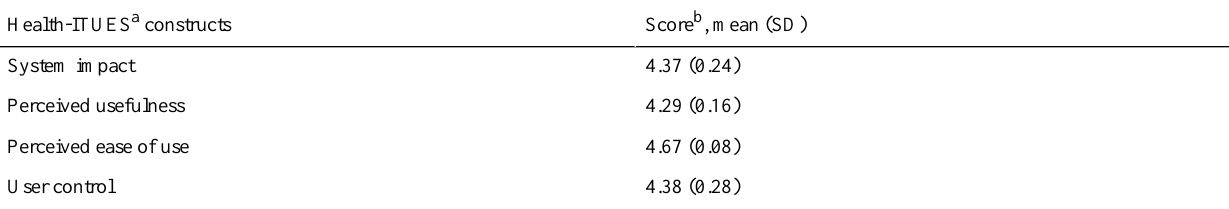
Table 2. Health Information Technology Usability Evaluation Scale